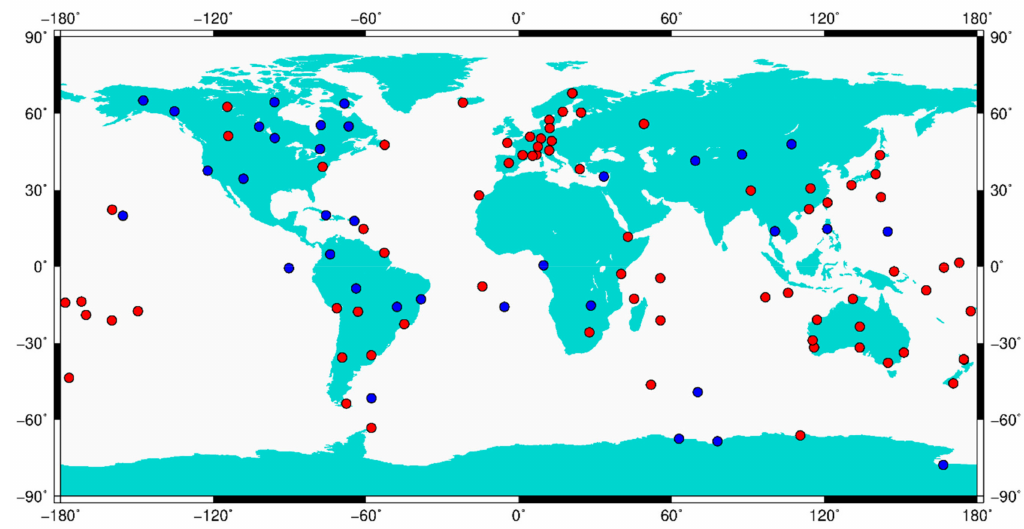
Figure 1. Distribution of stations selected: Stations marked in red contain GPS and BDS observation data; stations marked in blue only contain monitor GPS